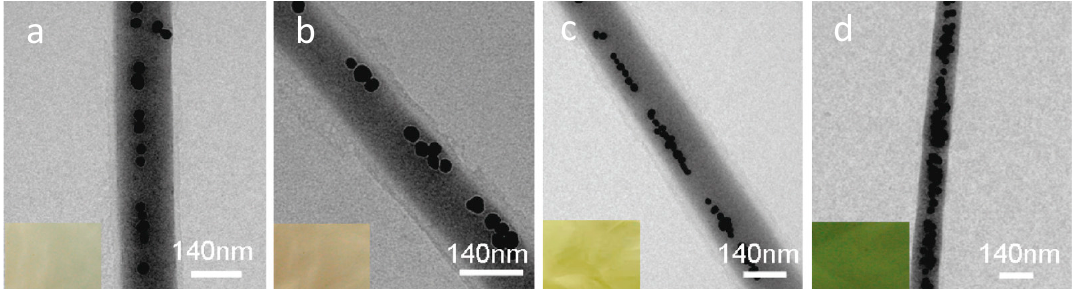
Figure 10. Typical TEM image of Ag/PVA nanofibers with the molar ratio of PVA/Ag ( a ) 530:1, ( b ) 530:2, ( c ) 530:3, and ( d ) 530:4. [159]. Reprinted from the ACS Nano, Vol 3, Xianfeng Wang, Dian He, Bo HuQiao-Feng, YaoKan Wang, and Shu-Hong Yu, Large-Scale synthesis of flexible free-Standing SERS substrates with high sensitivity: Electrospun PVA nanofibers embedded with controlled alignment of silver nanoparticles, 3993–4002, Copyright (2009) with permission from American Chemical Society.